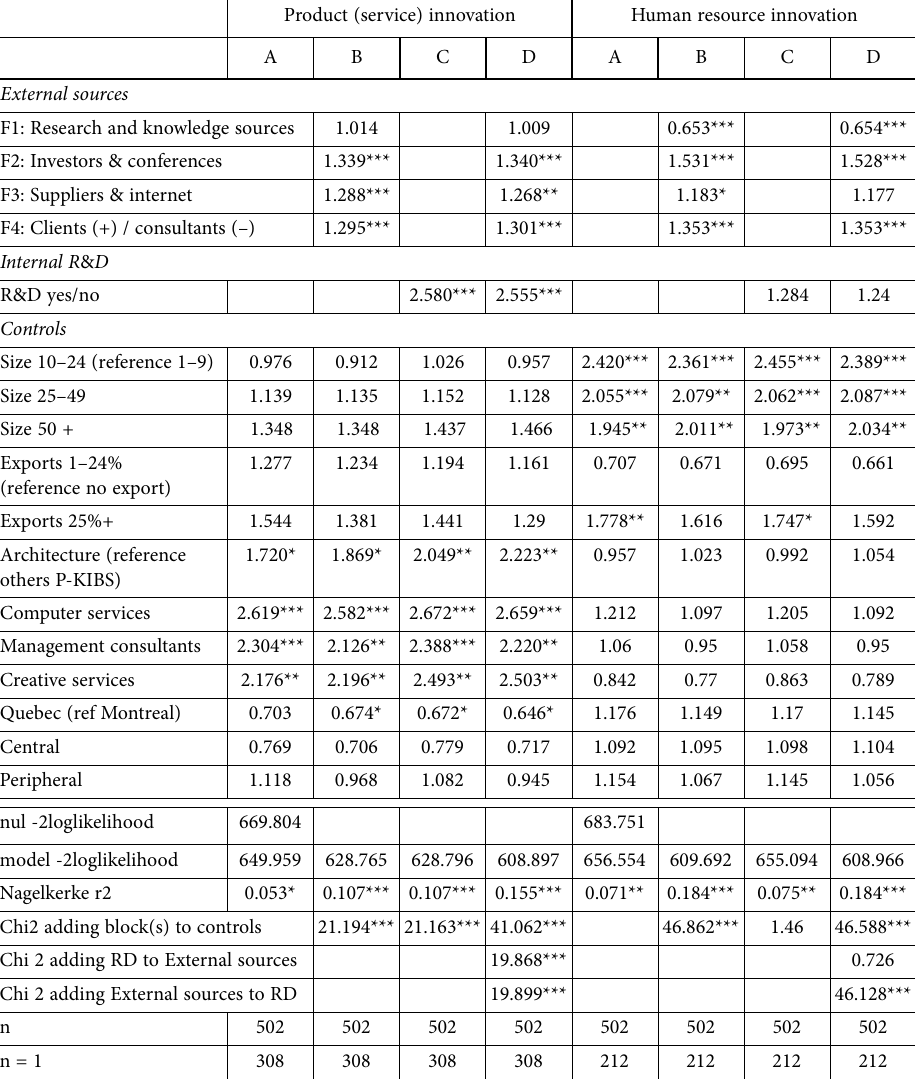
Table 2. The connection between external information sources, R&D and